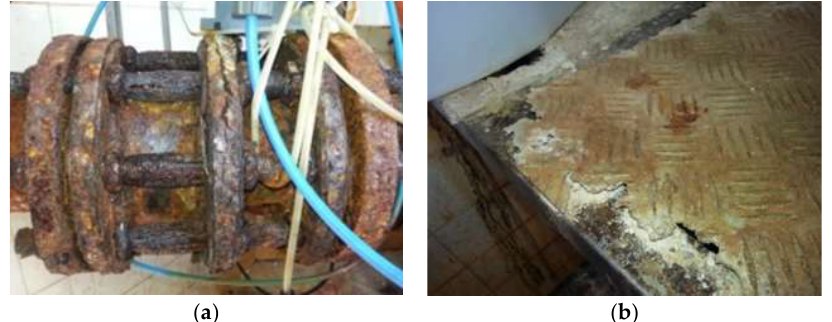
Figure A1. Joint screws on the reservoir water inlet pipe ( a ) and reservoir floor ( b ) uniform corrosion